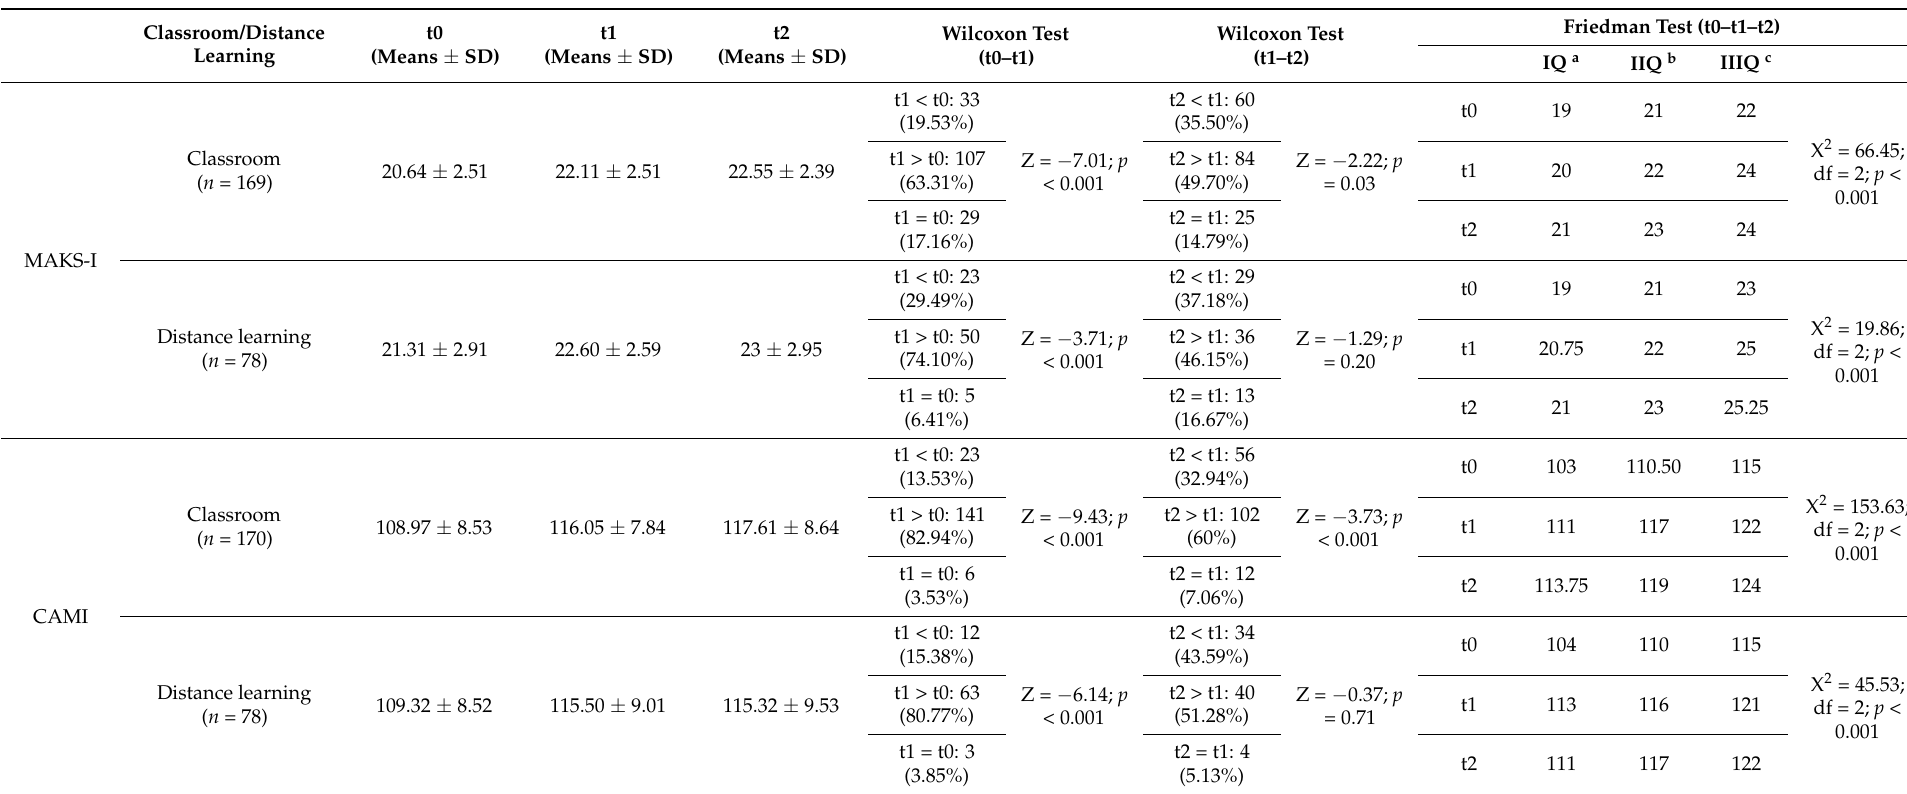
Table 4. Trend over time of the scores obtained in the knowledge of mental disorders (MAKS-I), the attitudes towards people who are mentally ill (CAMI), and the intended behaviour towards people with mental illness (RIBS-I) for students who attended in the classroom and those in distance learning. Classroom/Distance t0 Learning (Means ±